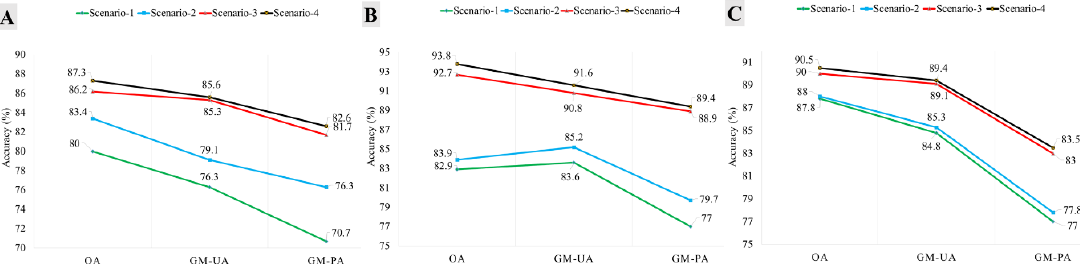
Figure 5. Mountain Land Cover (MLC) classification results based on the Random Forest (RF) algorithm and imbalanced samples over Site-1 ( A ), Site-2 ( B ), and Site-3 ( C ) using different classification scenarios (see subsection 3.2 for the explanations of the scenarios).